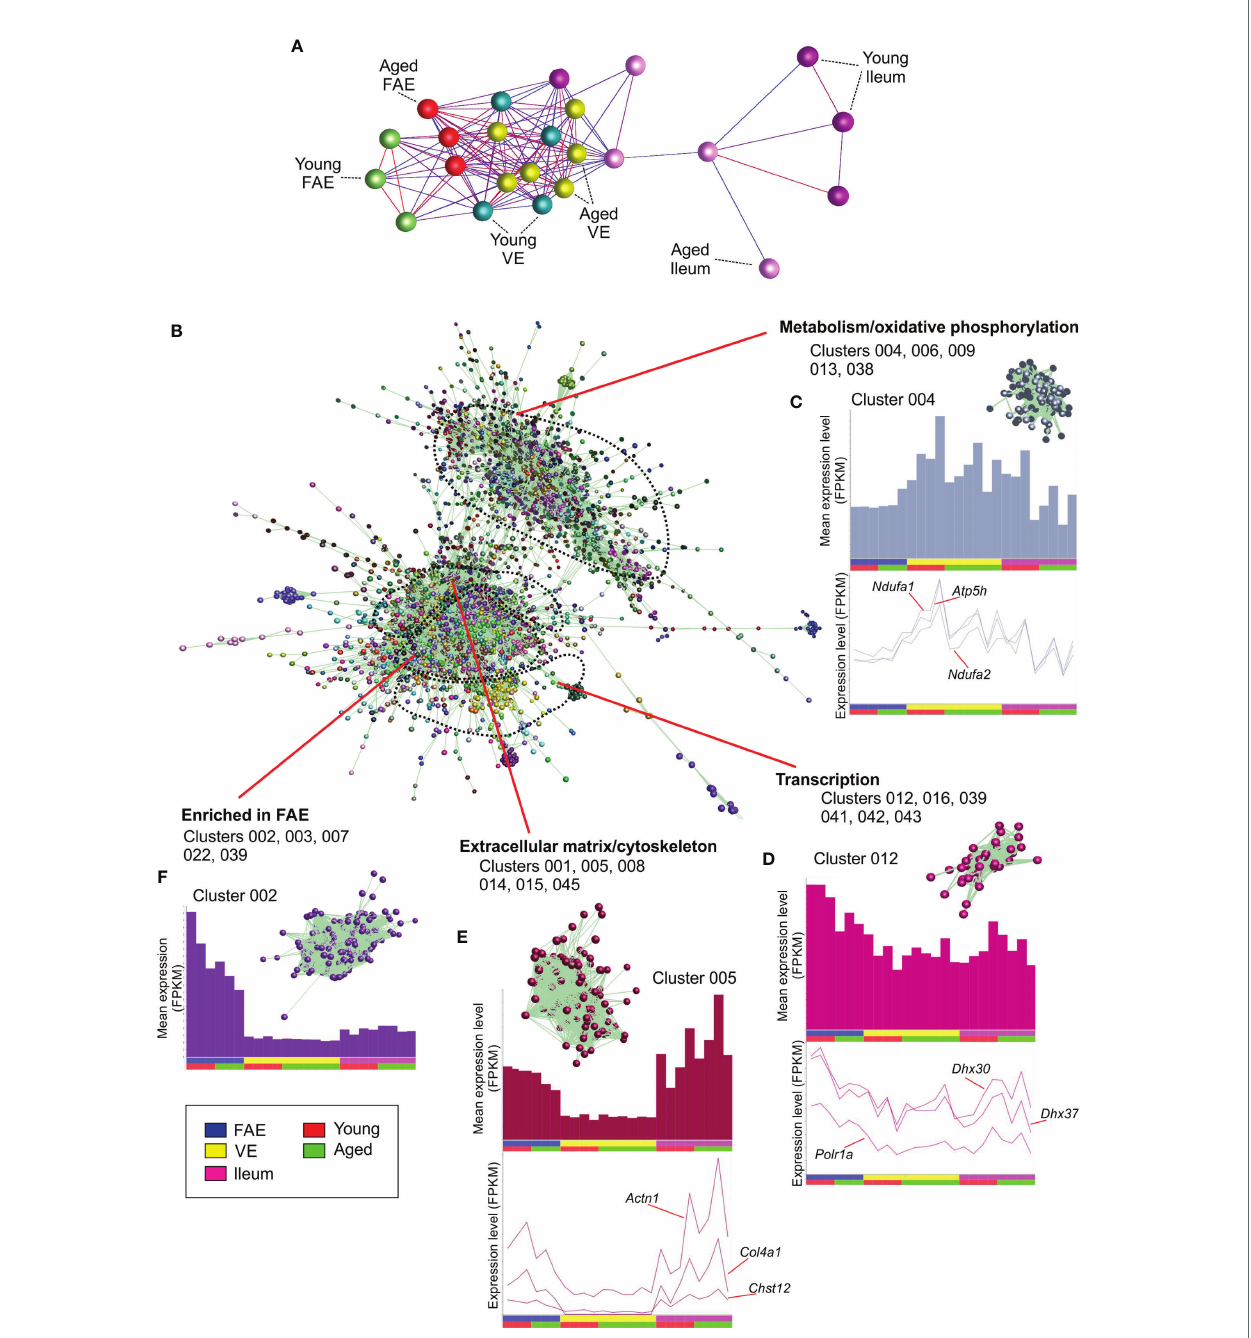
FIGURE 2 | Network co-expression analysis of mRNA-seq data sets from the FAE, VE and ileum from young and aged mice. (A) Clustering of samples based on their global gene expression pro fi les. A graph was created of the sample-to-sample correlations between each data set using Pearson correlation relationships of r ≥ 0.86 to de fi ne the edges. Nodes represent samples and the edges are colored using a scale based on the strength of the correlation (red, 1.0 - blue, 0.86). (B) Main network graph shows gene expression correlations at the transcript (gene) level across each of the 24 data sets using Pearson correlations between genes of r ≥ 0.93. Individual gene clusters are indicated by distinct colors, and the locations of speci fi c functional groupings of clusters are indicated. (C – F) Upper panels show the average expression pro fi les (mean FPKM) of the genes in the selected clusters across the 24 data sets, with each bar representing the mean expression level in an individual data set. The insets in the upper panel show the grouping of nodes in the selected cluster from the network graph in (B) Lower panels show the expression pro fi les (FPKM) of selected genes across the 24 data